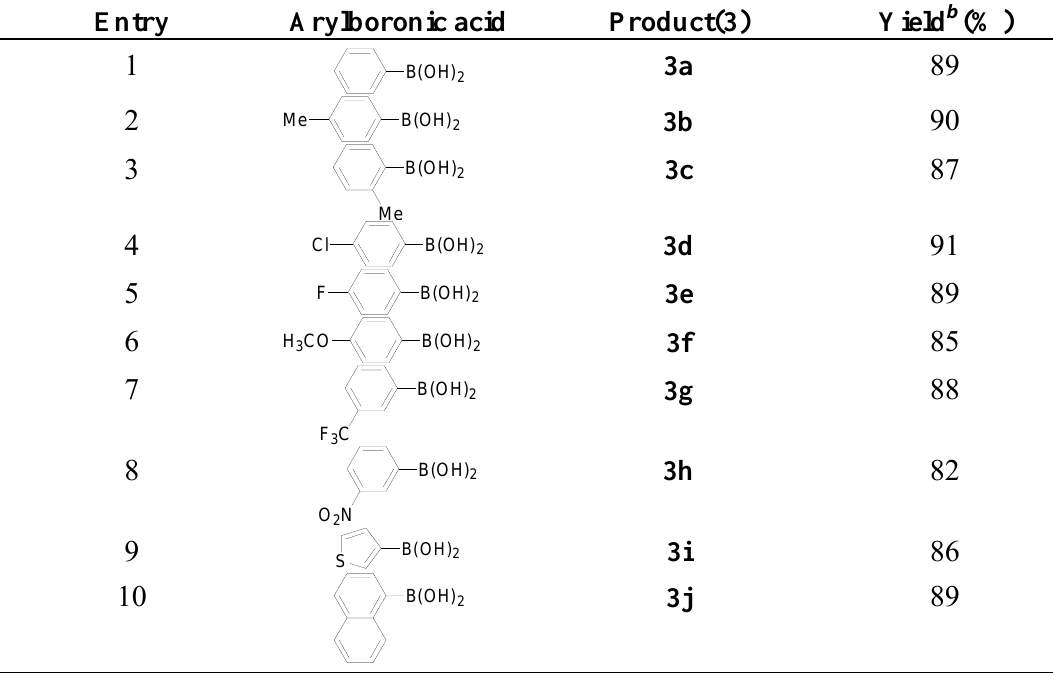
a Reaction conditions: 2,3,5-trichloropyridine (1 mmol), arylboronic acid (1.5 mmol), Na